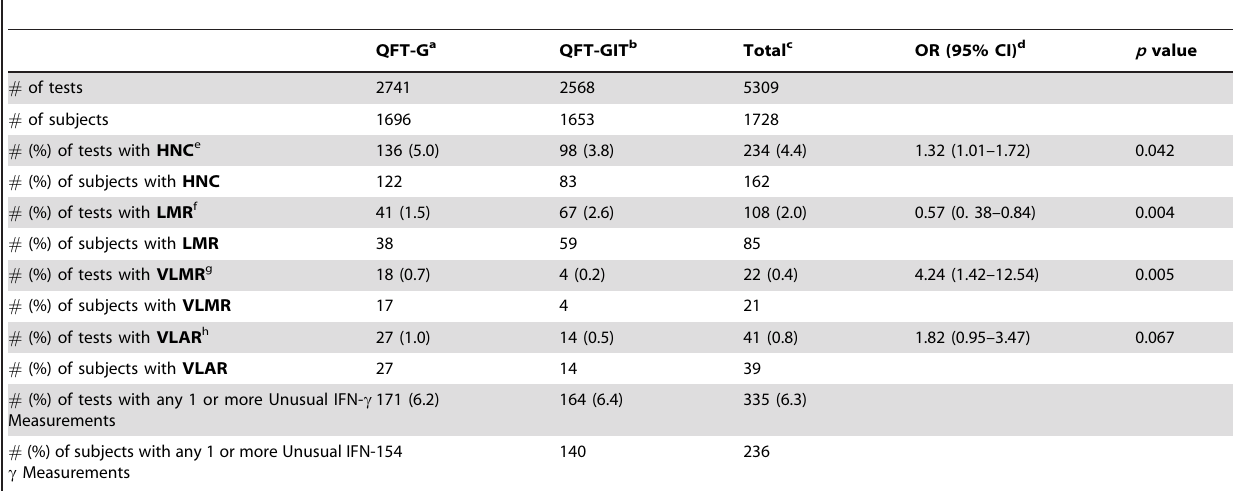
Table 2. Frequency of Unusual IFN- c Measurements with QuantiFERON-TB Gold and QuantiFERON-TB Gold In-Tube